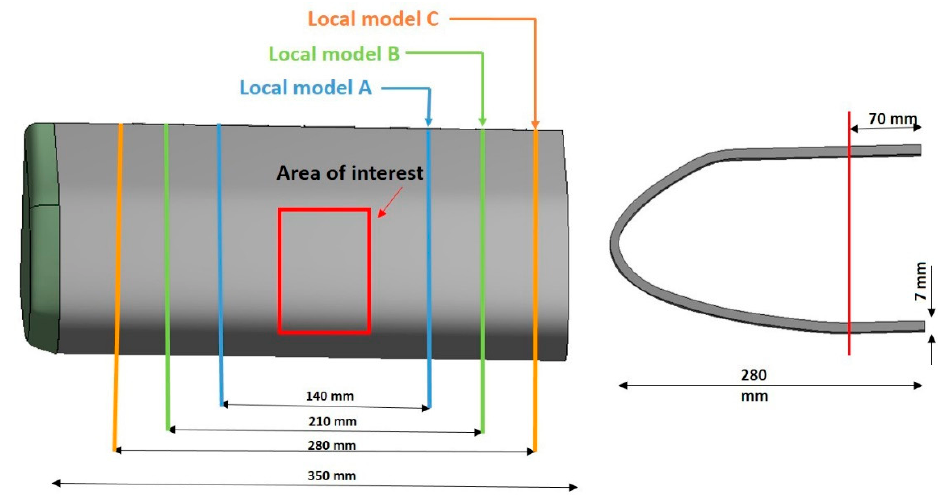
Figure 4. Location and size of Local Models.